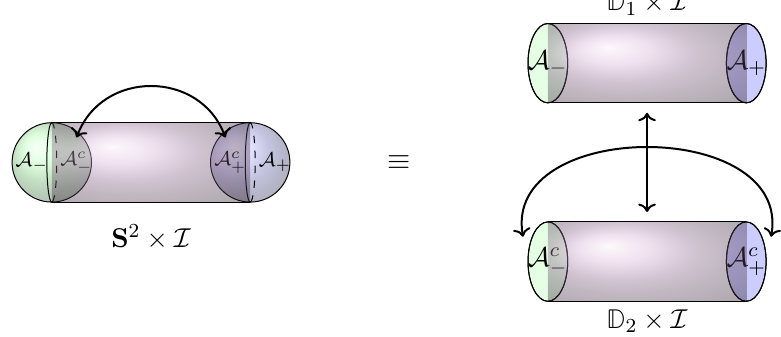
Figure 26 . The path integral over S 2 (cid:2) I can be understood as the path integrals over D 1 (cid:2) I and D 2 (cid:2) I glued along the boundaries @ (cid:26) is obtained by gluing this path integral along the regions A c b A